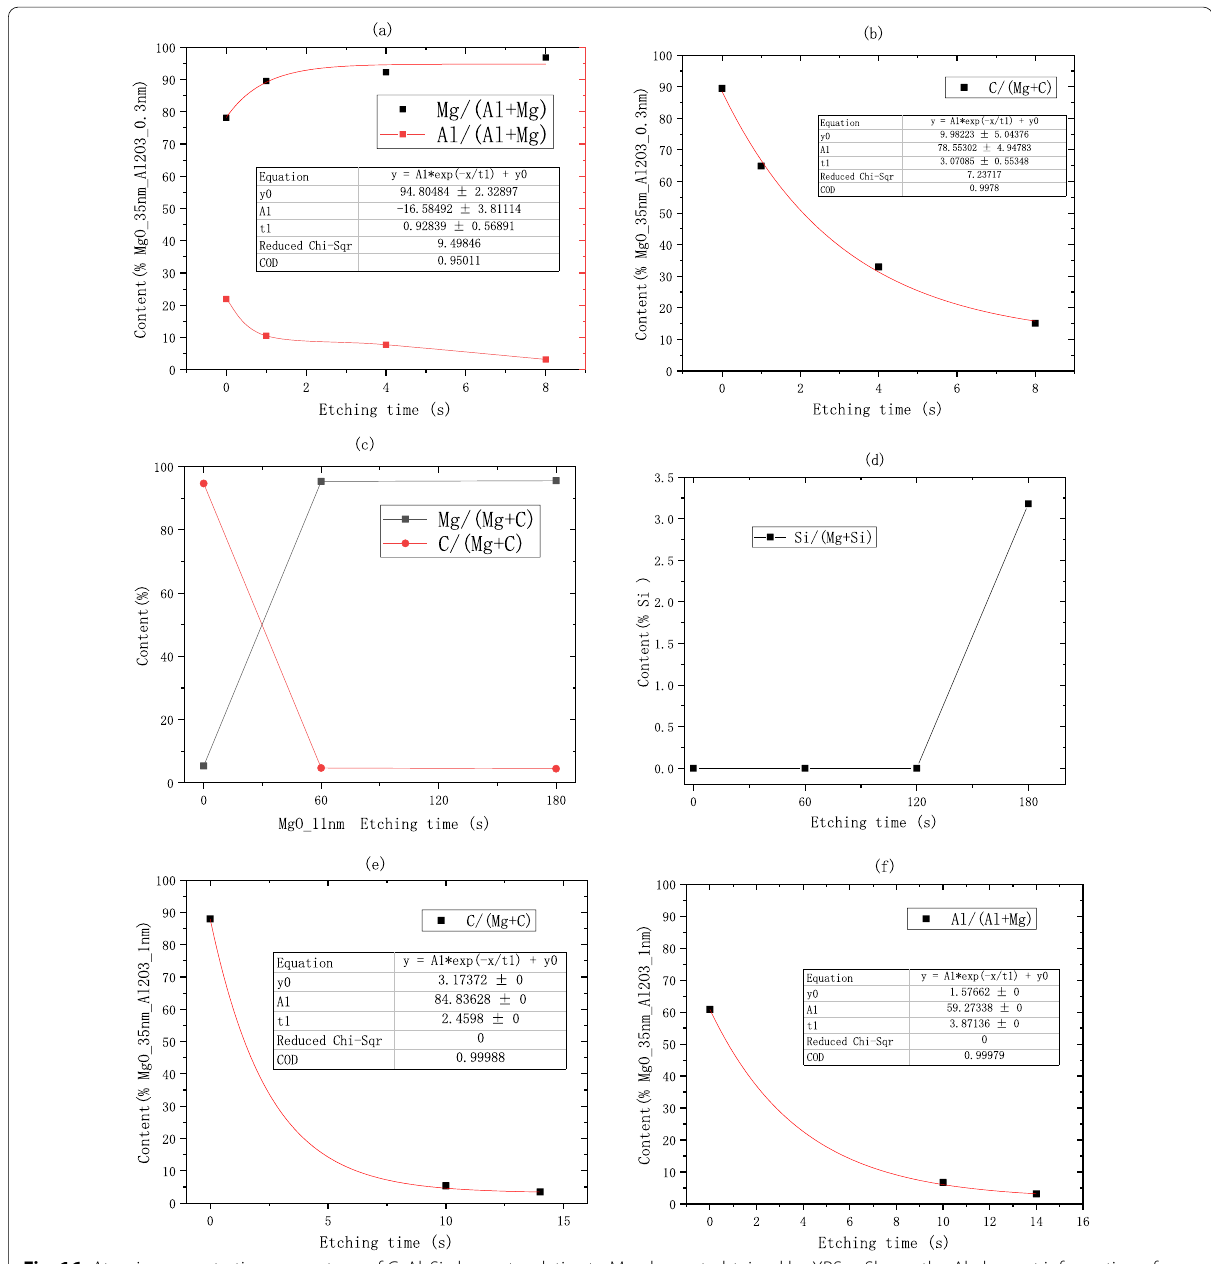
Fig. 16 Atomic concentration percentage of C, Al, Si elements relative to Mg element obtained by XPS. a Shows the Al element information of deliquescent MgO/Al 2 O 3 (on the silicon wafer, grow 35 nm-MgO, and then grow 0.3 nm-Al 2 O 3 ), a shows the C element information of deliquescent MgO/Al 2 O 3 (on the silicon wafer, grow 35 nm-MgO, and then grow 0.3 nm-Al 2 O 3 ), c shows the C element information of deliquescent MgO (on the silicon wafer, grow 11 nm-MgO), d shows the Si element information of deliquescent MgO (on the silicon wafer, grow 11 nm-MgO), e shows the C element information of deliquescent MgO/Al 2 O 3 (on the silicon wafer, grow 35 nm-MgO, and then grow 1 nm-Al 2 O 3 ). f shows the Al element information of deliquescent MgO/Al 2 O 3 (on the silicon wafer, grow 35 nm-MgO, and then grow 1 nm-Al 2 O 3